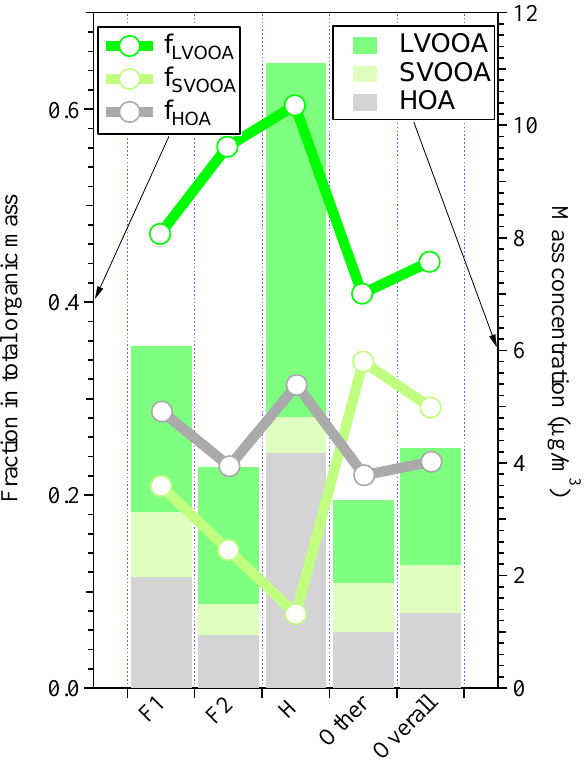
Fig. 2. Mass fraction and concentration of hydrocarbon- like organic aerosols (HOA), semi-volatile oxygenated organic aerosols (SVOOA), and low-volatility oxygenated organic aerosols (LVOOA) during five periods: foggy periods (F1 and F2), hazy period (H), non-foggy and non-hazy period (“other”), and overall pe-